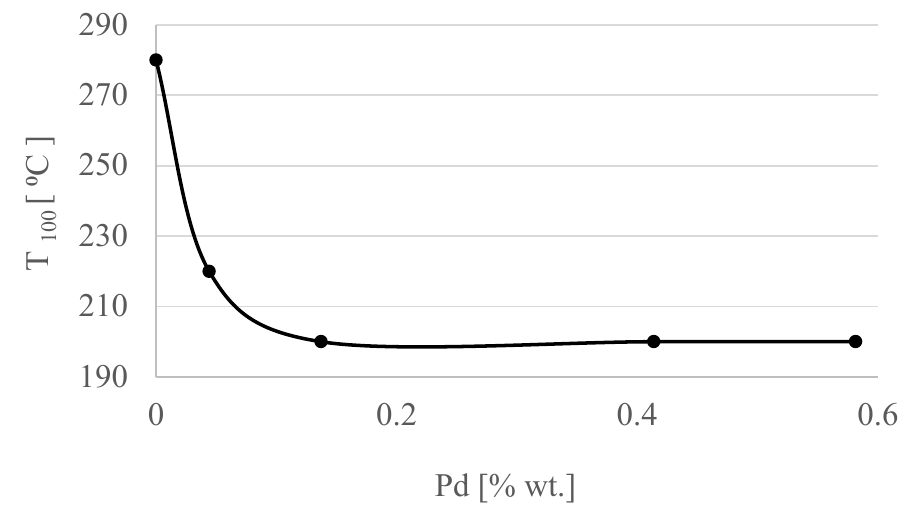
Figure 9. Relationship between T 100 (°C) and Pd (% wt.).